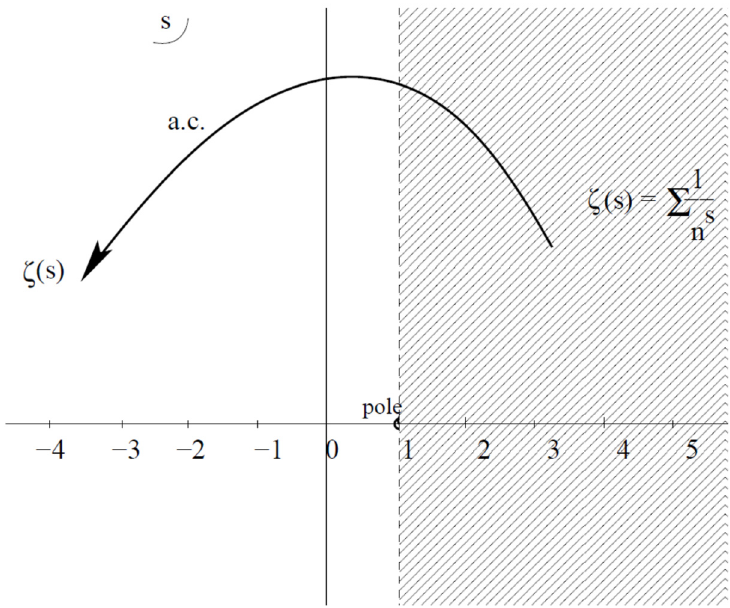
Figure 3. Definition of the Riemann zeta function on the complex plane.